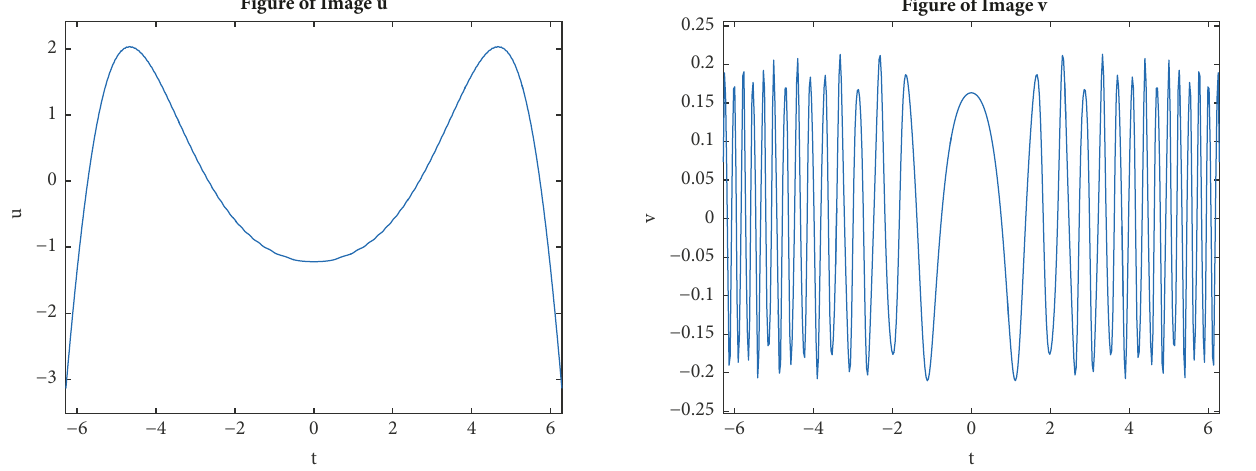
Figure 3: 𝑥 = 0.9 , 𝑙 1 = 0.3 , 𝑙 2 = 0.5 , 𝑙 3 = 0.8 , 𝑚 1 = 1 , 𝑚 2 = 2 , 𝑦 = 3 , and 𝑡 ∈ [−6,6] .